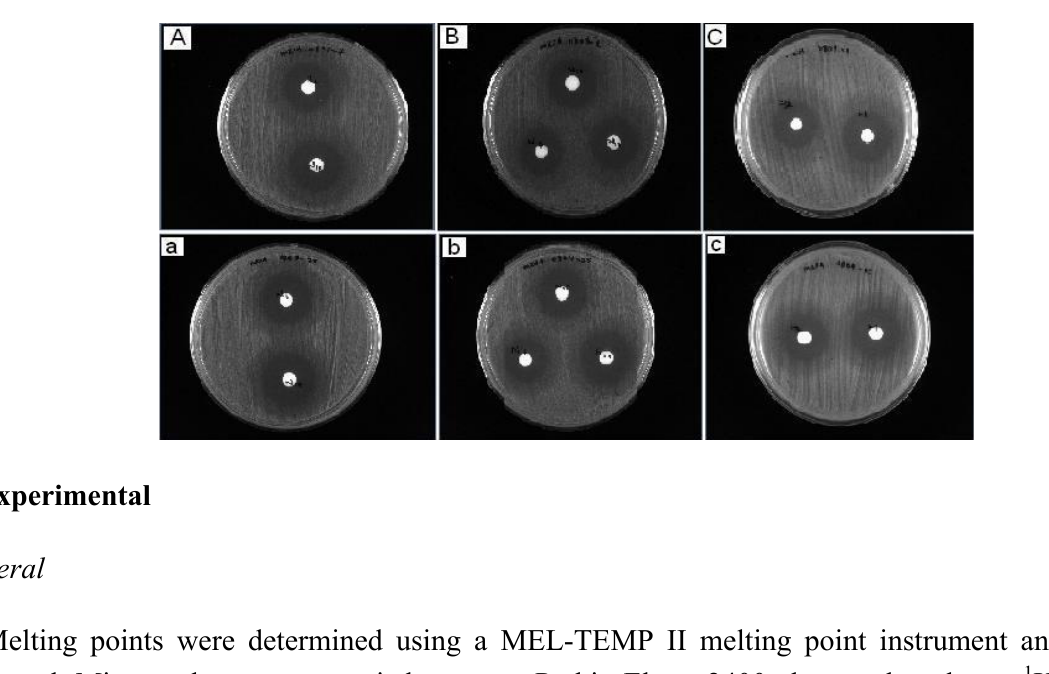
E = erythromycin; GN = gentamycin; LZD-linozolid acid; MUP = muciprocin; RD- rifampicin; DA = clindamycin; TEC = teicoplanin; CIP = ciproflozaxin; NET = netilmycin; TE = tetracycline; VA = vancomycin; FD = fusicidic acid; OX = oxacilin; SXT = Trimethoprim-sulfamethaxazole; R = resistant; S = sensitive; I = intermediate resistant. Figure 3. Photograph showing the antibacterial (MRSA 0804-25-A,B,C) and (MRSA 0807-7-a,b,c)